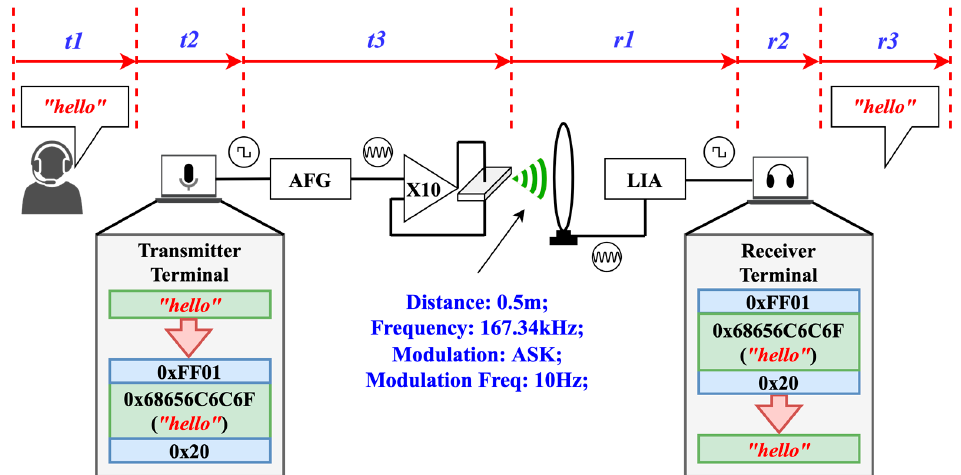
Figure 6. A case of an end-to-end communication process.